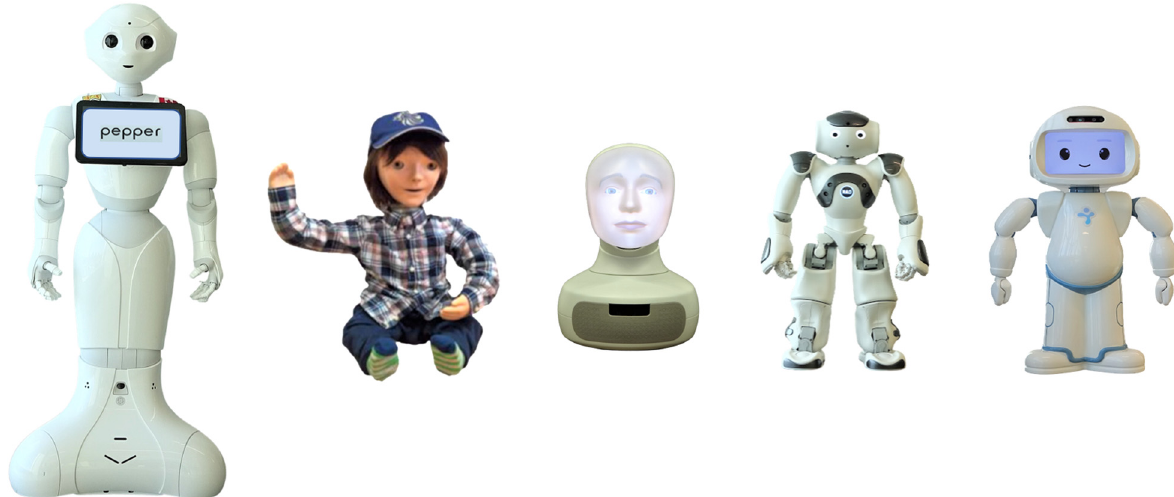
Figure 1: Examples of social robots that have been used in the fi elds of therapy and healthcare. Left to Right: Pepper ( 2014 - present, Source: Softbank Robotics ) ; Kaspar ( 2009 - present, Source & credit: The Adaptive Systems research group, University of Hertfordshire ) ; Furhat ( 2014 - present, source: Furhat Robotics AB ) ; Nao ( 2006 - present, source: Softbank Robotics ) ; QT ( 2018 - present, LuxAI )